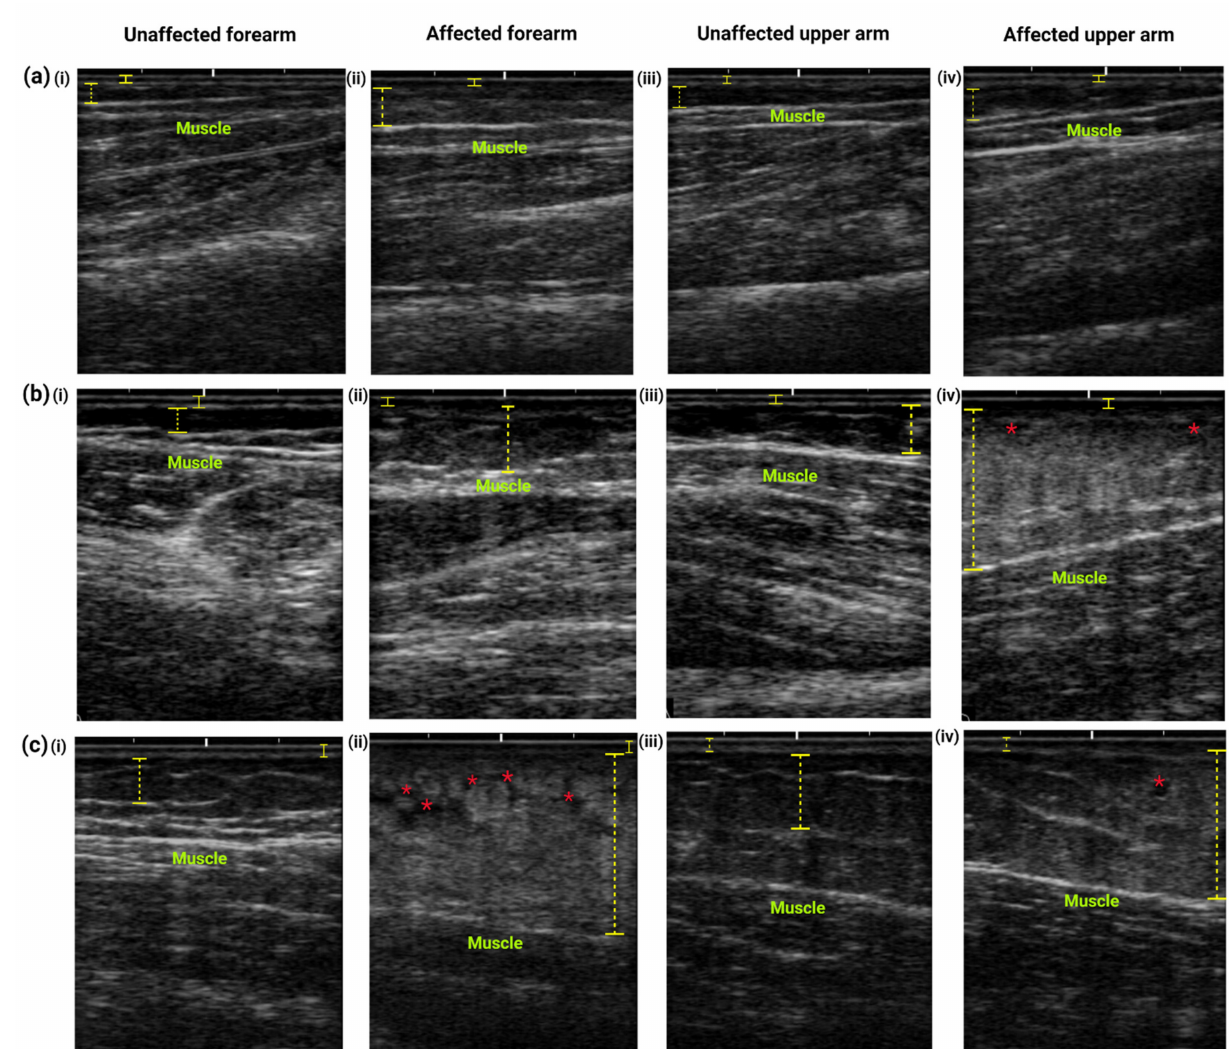
Figure 5. Typical images of ultrasound examination of the ( i ) unaffected forearm, ( ii ) affected forearms, ( iii ) unaffected upper arm and ( iv ) affected upper arm performed on women with ( a ) mild and ( b,c ) moderate to severe stage lymphedema. The structures of the skin measured included the dermis and epidermis layers (yellow straight lines) and the subcutaneous layer (yellow discontinuous lines). The images of the unaffected forearm and upper arm display typical skin structure with normal anatomical structures of the dermis, subcutaneous, and muscle layers. Mild lymphedema is characterized by thickening of subcutaneous layer at the ( a ( ii )) forearm and ( a ( iv )) upper arm. In contrast, tissue changes occur mainly at the subcutaneous area, as lymphedema progresses. As demonstrated in ( b,c ) , tissue thickness increased in the affected arms ( b ( ii,iv ) and c ( ii,iv )) due to accumulation of fluid in the subcutaneous tissue (indicated by hyperechogenic tissue), which is associated with higher stages of lymphedema. A blurring interface between the subcutaneous and dermis layers is also observed in the affected arms ( b ( ii,iv ) and c ( ii,iv )). Prominent subcutaneous edema and fat lobules give the cobblestone or lattice pattern (red asterisks), indicating soft tissue changes that often occur in the subcutaneous